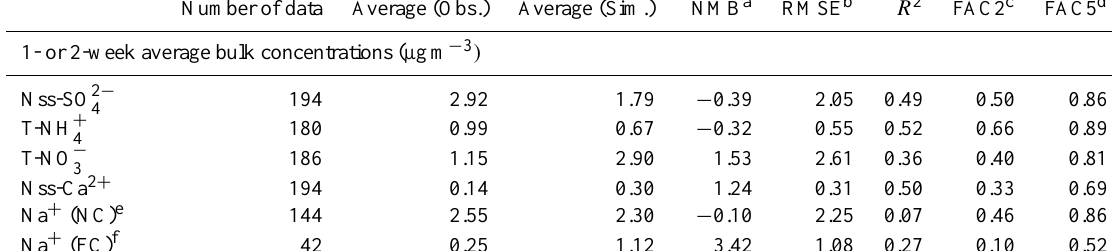
Table 2. Comparative statistical analysis of all observed (Obs.) and simulated (Sim.) data for the year 2006. Number of data Average (Obs.) Average (Sim.) NMB a RMSE